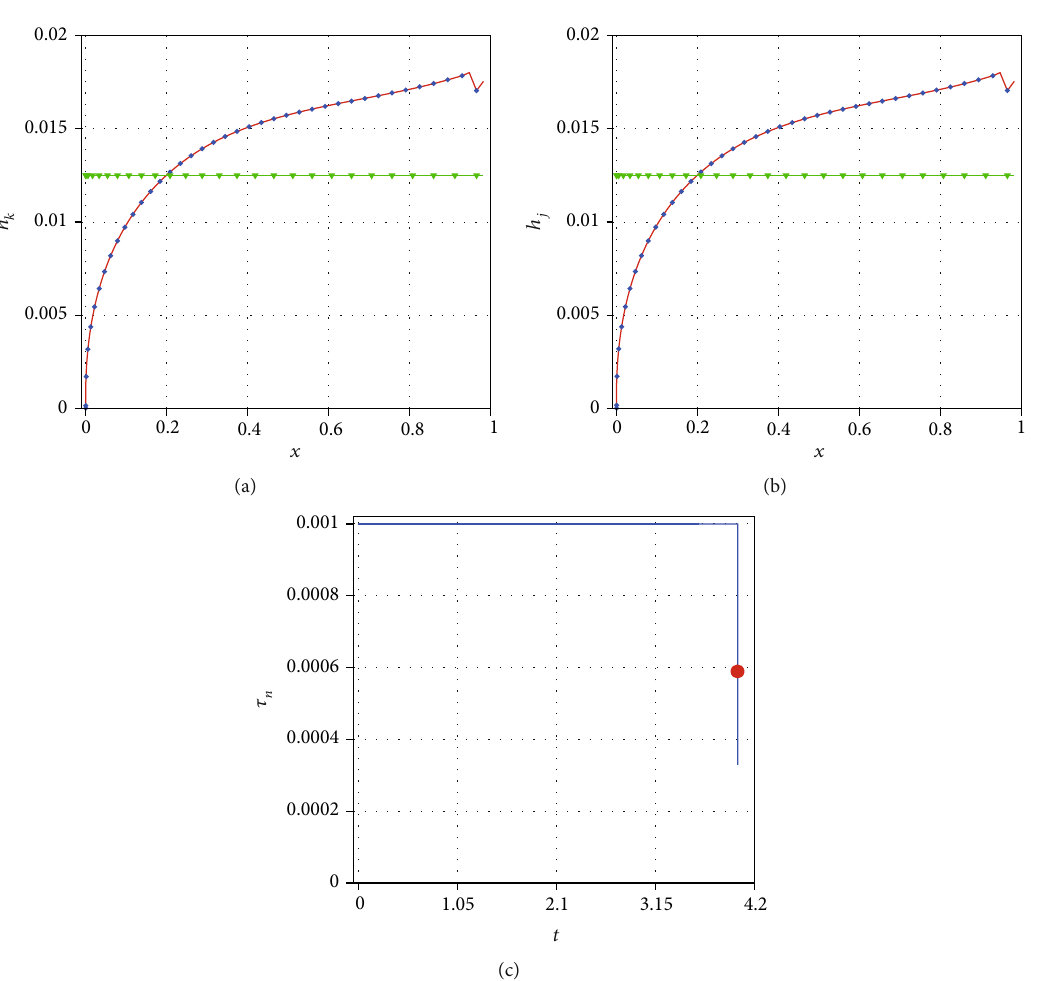
y processes; (c) the curve of the j as space ffiffiffiffiffiffiffiffiffiffiffiffi p 11000 based on convection term b / ð α x + β y Þ .